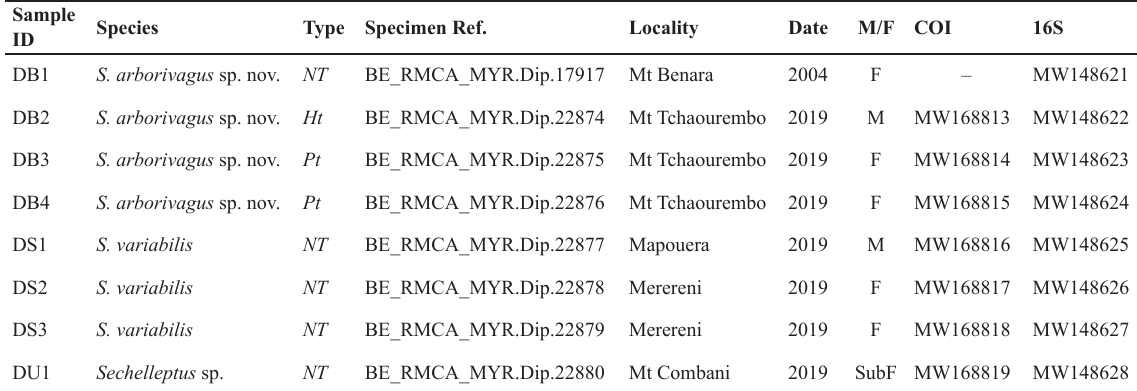
Table 1. List of the sequenced specimens of Sechelleptus Mauriès, 1980, with DNA sample ID, Type specimen (Ht = Holotype; Pt = Paratype; NT = non type), Museum and collection information, sex stage (F = female; M = male; SubF = sub-adult female) and GenBank accession number for COI and 16S rRNA